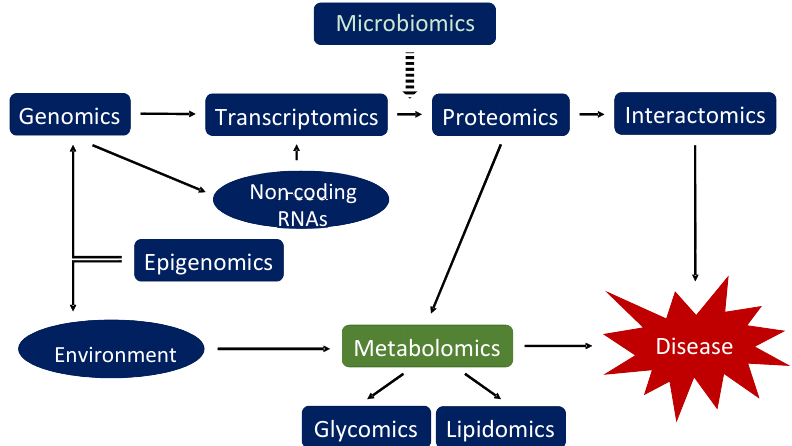
Figure 3. Overview of the various omics approaches that can be applied to assess the biological components that contribute to multifactorial diseases, such as age-related macular degeneration (AMD). Metabolomics is highlighted in green as an approach to test the effect of the environment and processes in the body on the development of disease. Microbiomics is growing in importance in understanding disease, but how it influences the whole system in a human, or in fact in animals, is yet to be determined. Adapted from Lauwen et al.